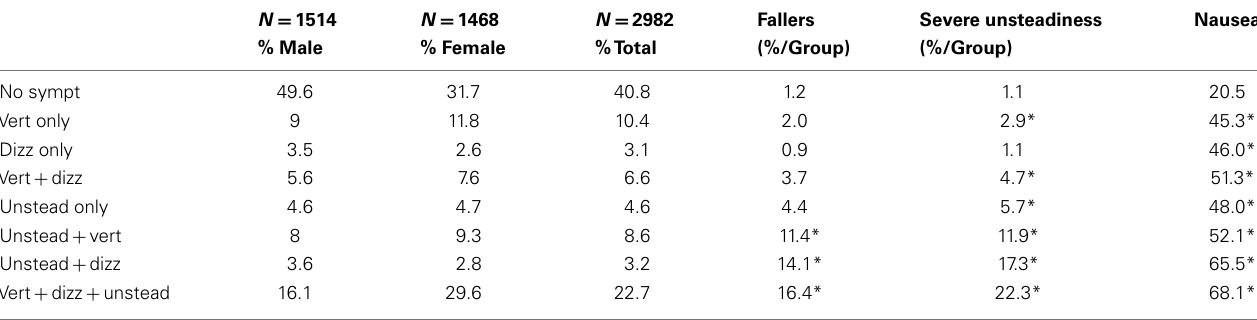
Table 2 |The prevalence of combinations ofVDU and balance-related fallers, severe unsteadiness, and nausea. N =